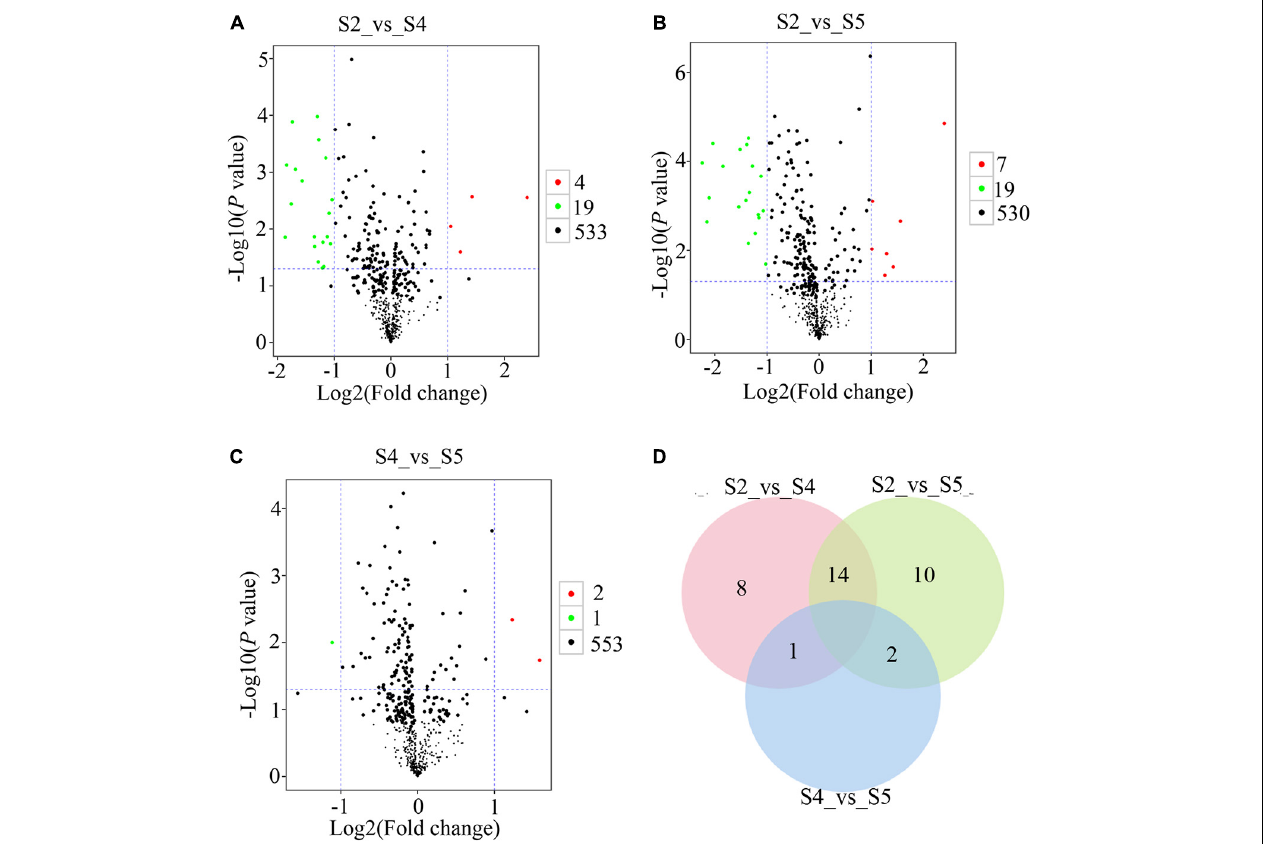
FIGURE 5 | Metabolomic GC-TOF-MS-based analyses of the C . sinense ovule at three developmental stages (S2, S4 and S5). Visualization, using volcano plots, of the identified metabolites from S2_vs_S4 (A) , S2_vs_S5 (B) , and S4_vs_S5 (C) comparisons. Green dots in the graph represent down-regulated DAMs, red dots represent up-regulated DAMs, and black represents metabolites that were detected but were not significantly different. (D) Venn diagram for the number of unique and overlapping DAMs from S2_vs_S4, S2_vs_S5 and S4_vs_S5